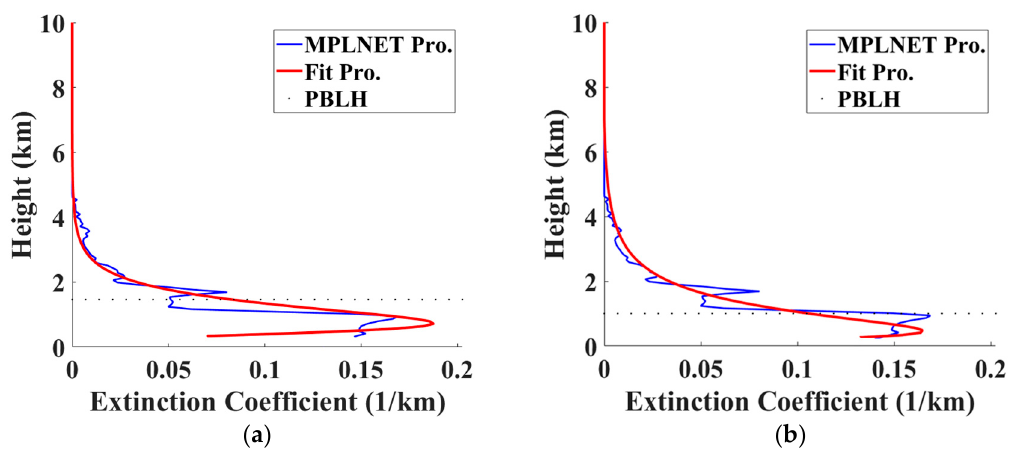
Figure 12. Comparison of the fitted extinction profile (red line) with measurements from the MPLNET NCU_Taiwan site (blue line) using ( a ) the Global Modeling and Assimilation Office (GMAO) PBLH and ( b ) the MPL PBLH at 11:00 LT on October 29, 2014.